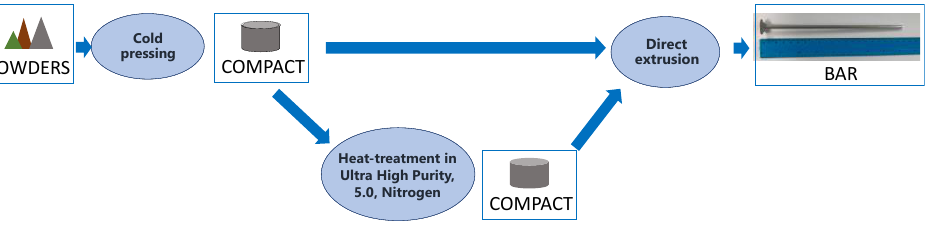
Figure 3. Process scheme of the experimental procedure.